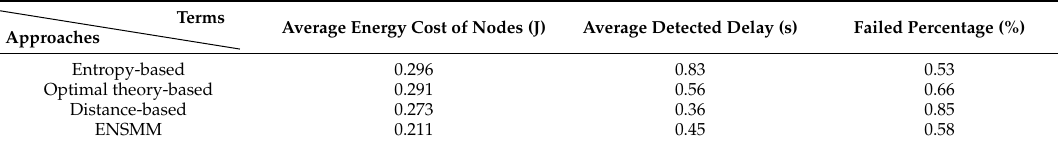
Table 4. Comparison of different approaches in surveillance